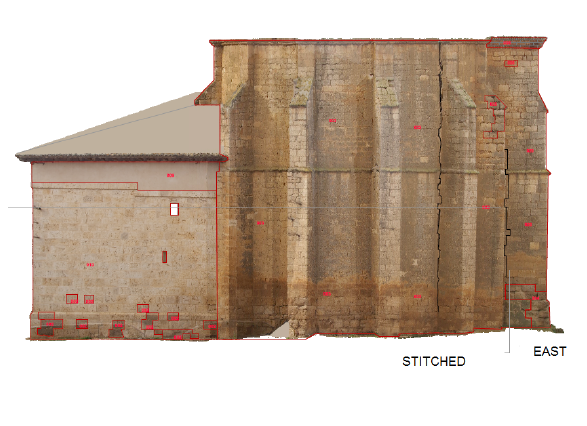
Figure 5: Church of San Pedro in Becerril de Campos (Palencia,